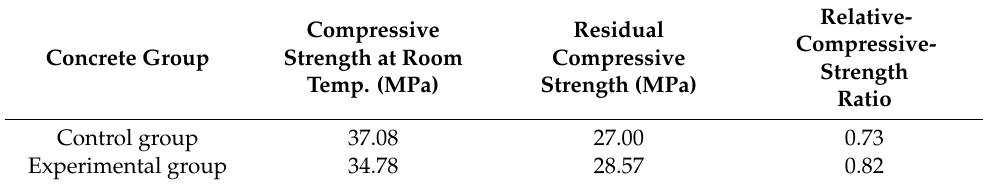
Table 10. Relative-elastic-modulus ratio of the compressive failure specimen after self-healing. Concrete Group